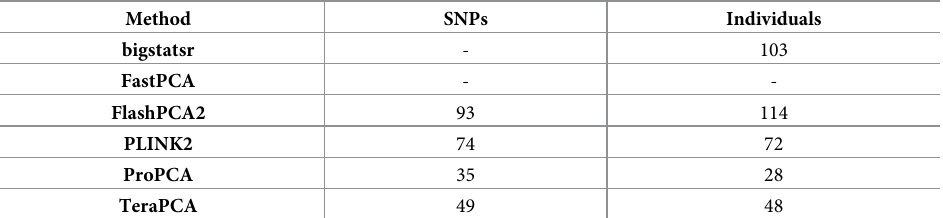
Table 2. Runtimes of methods on largest simulated datasets for 40 principal